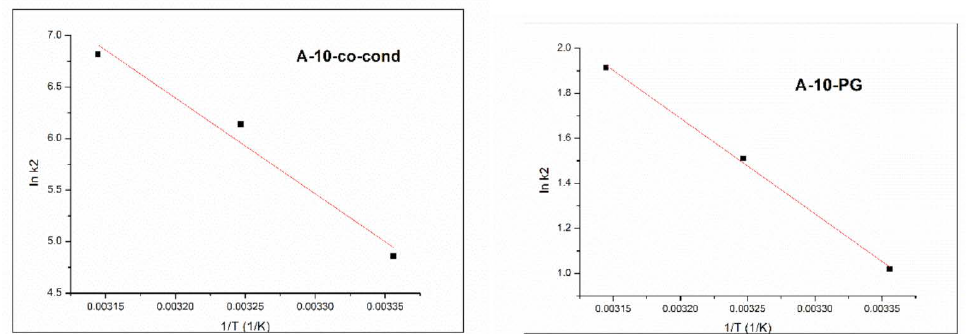
Figure 11. Arrhenius plots for adsorption process for the A-10-co-cond ( left ) and A-10-PG ( right )